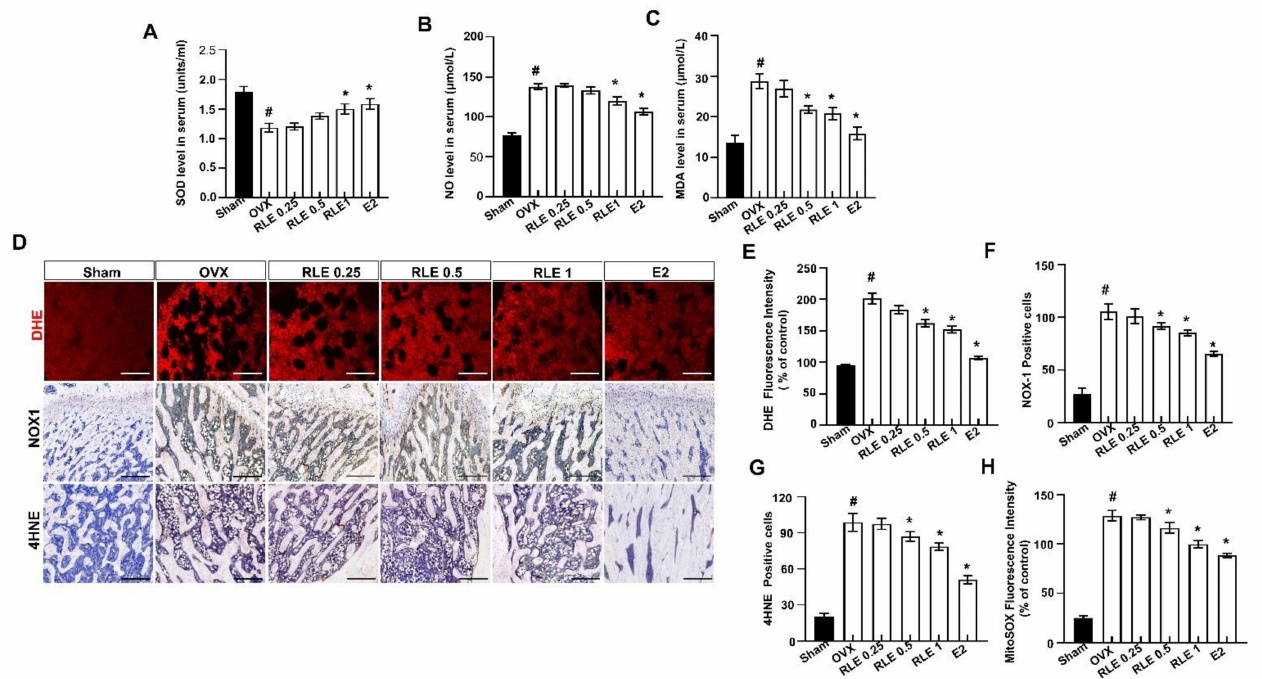
Figure 6. RLE regulates production of ROS in the bone tissues of the OVX rats. ( A ) SOD, ( B ) NO, and ( C ) MDA levels in rat serum. ( D ) Images of immunofluorescence staining DHE. Representative femur sections for NOX-1 and 4HNE by immunohistochemistry (IHC). ( E ) Quantitative analysis of DHE fluorescence intensity. ( F ) NOX-1- and ( G ) 4HNE-positive cells were counted and quantified relatively. ( H ) Quantitative analysis of MitoSOX fluorescence intensity. Data are shown as mean ± SEM. ( n = 10, # p < 0.05 vs. sham; * p < 0.05 vs. OVX). Sham, sham-operated group; OVX, ovariectomy; RLE, Ramie leaf extract; SOD, superoxide dismutase; NO, nitric oxide; MDA, malondialdehyde, 4HNE;